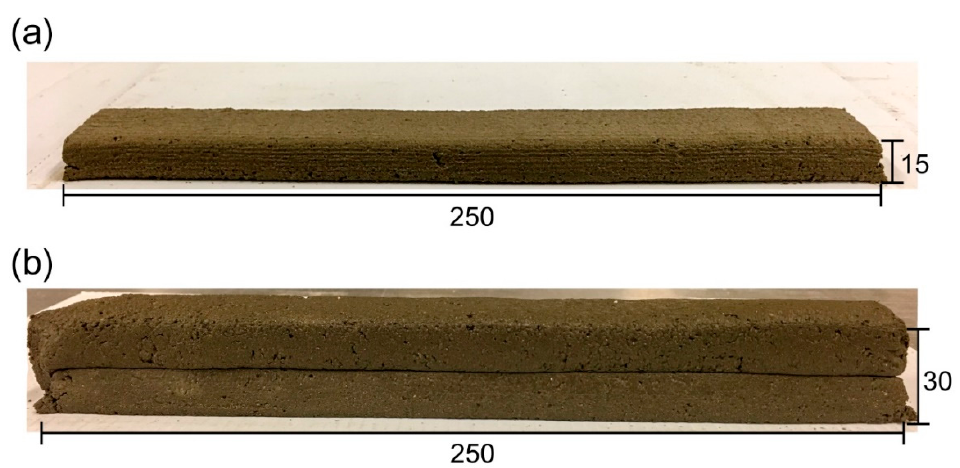
Figure 2. Schematic drawing of the custom-made 3D printing apparatus.